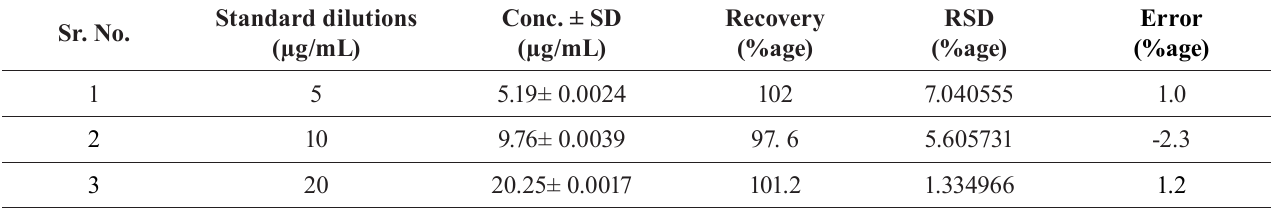
TABLE II - Inter-day accuracy and precision analysis (n = 6)